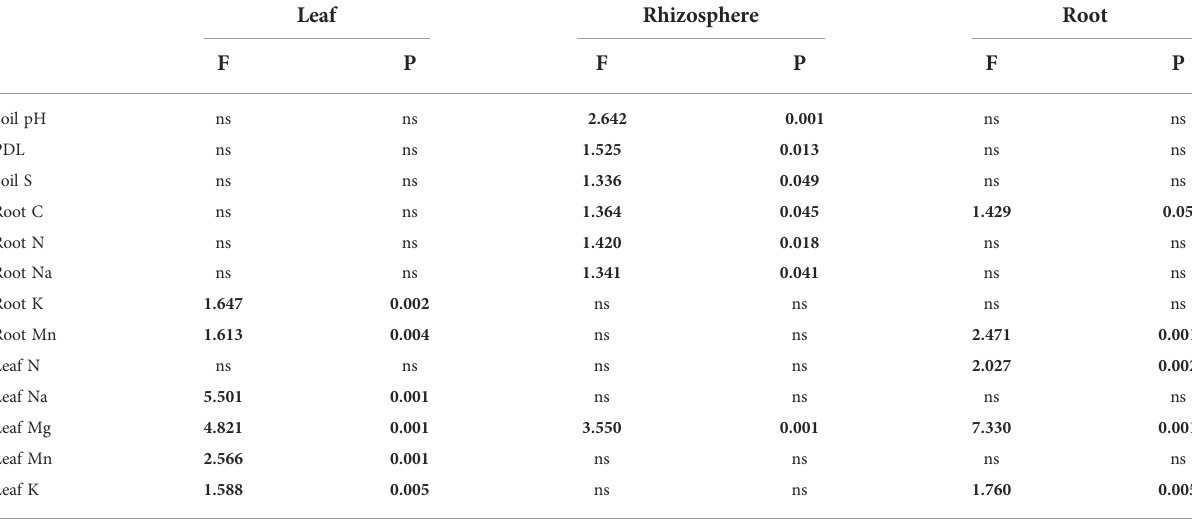
TABLE 3 Relationships between the predictor soil and plant properties and the mycobiota in the leaf, rhizosphere and root